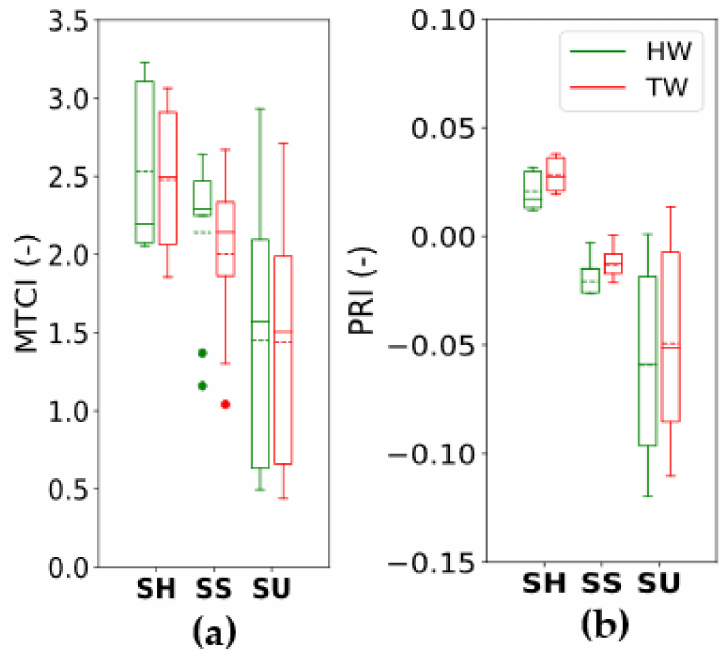
Figure 8. Comparison of ( a ) Meris terrestrial chlorophyll index (MTCI) and ( b ) photochemical reflectance index (PRI) obtained using horizontal white (HW) and at-target white (TW) references. The results are grouped by light growth conditions, as described in the capture of Figure 5. The dashed line of the boxplot represents the mean value, continuous line represents the median